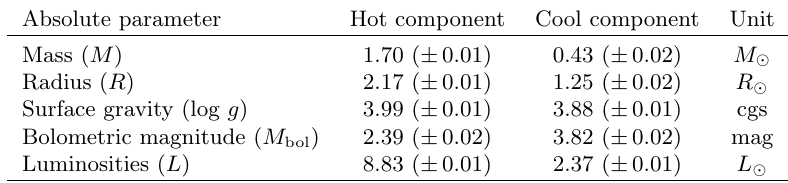
Table 5. Absolute physical parameters of V407 Peg obtained by the simultaneous analysis of the light and radial velocity